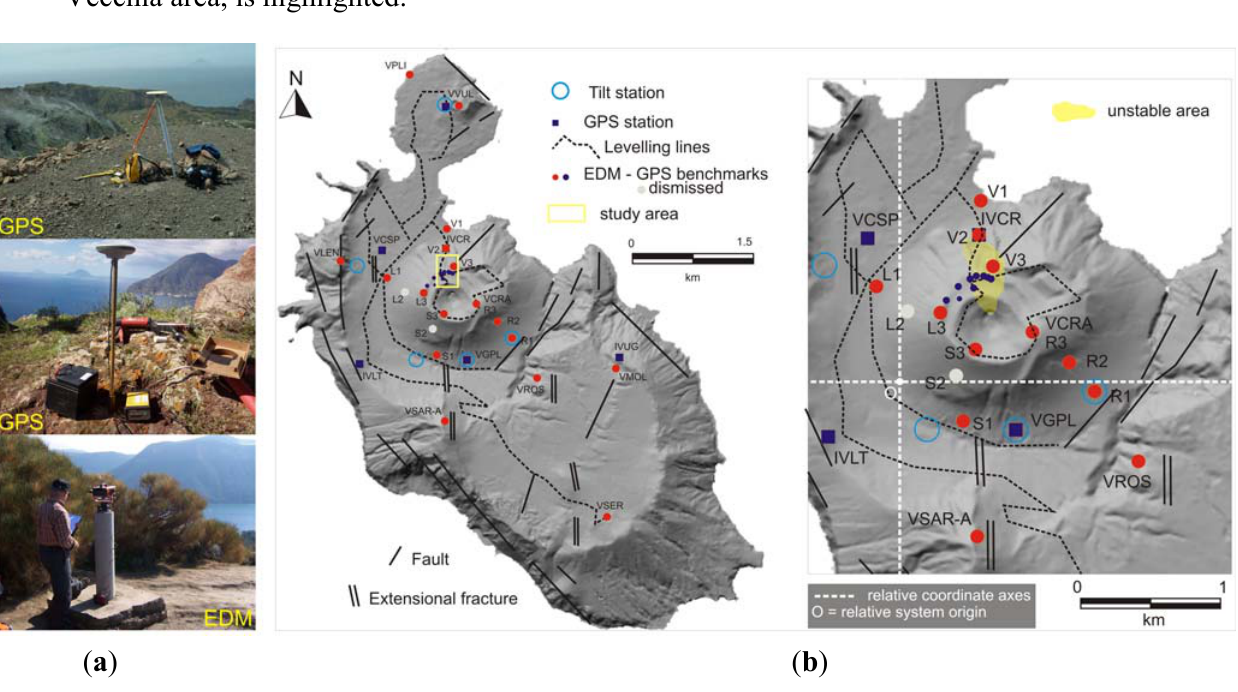
Figure 1. Vulcano Island geodetic and geographic setting. ( a ) Main faults, fractures system and monitoring network: the points where GPS, electro-optical distance measurements (EDM) and leveling systems are shown (see images on the left inserts for typical installations); ( b ) the La Fossa cone, where the northern unstable zone, i.e. , the Forgia Vecchia area, is